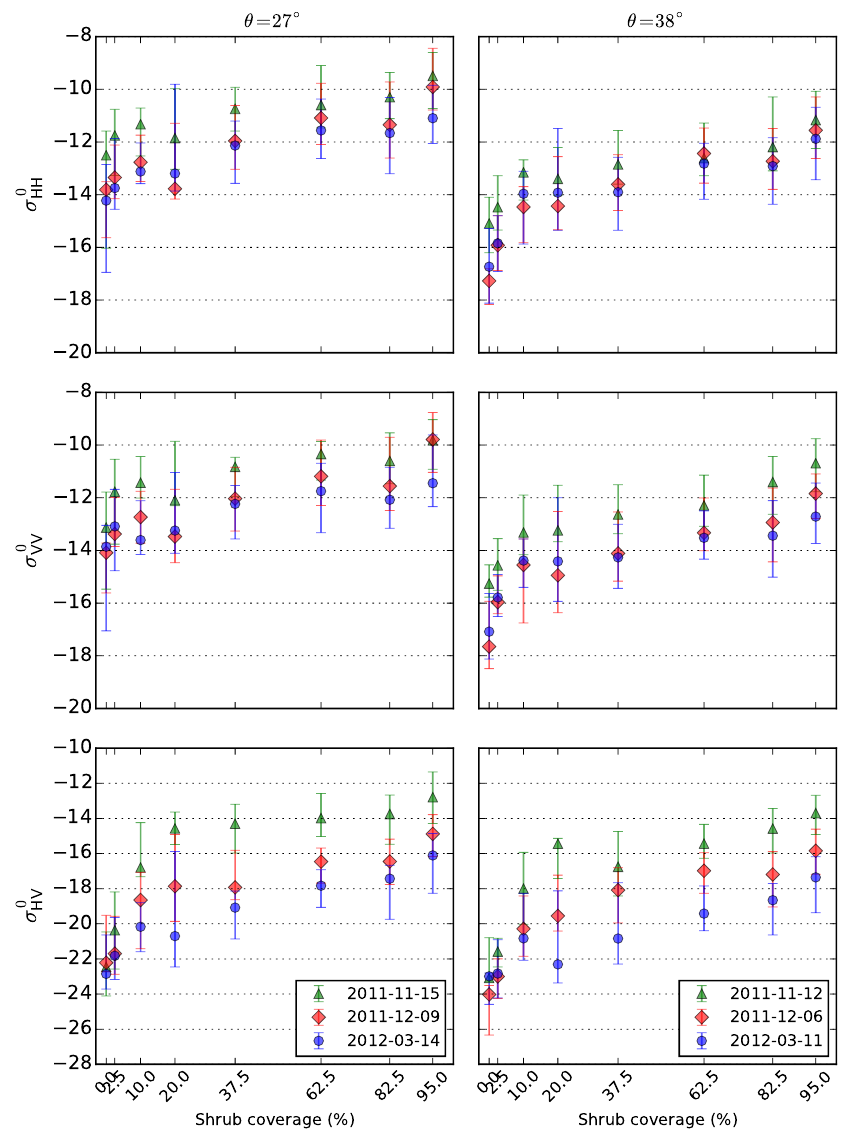
Figure 5. RADARSAT-2 backscattering response to shrub coverage comparing November, December and March acquisitions; the left column displays incidence angle θ = 27 ◦ and the right column θ = 38 ◦ . The markers represent the median values and the error bars the lower and upper